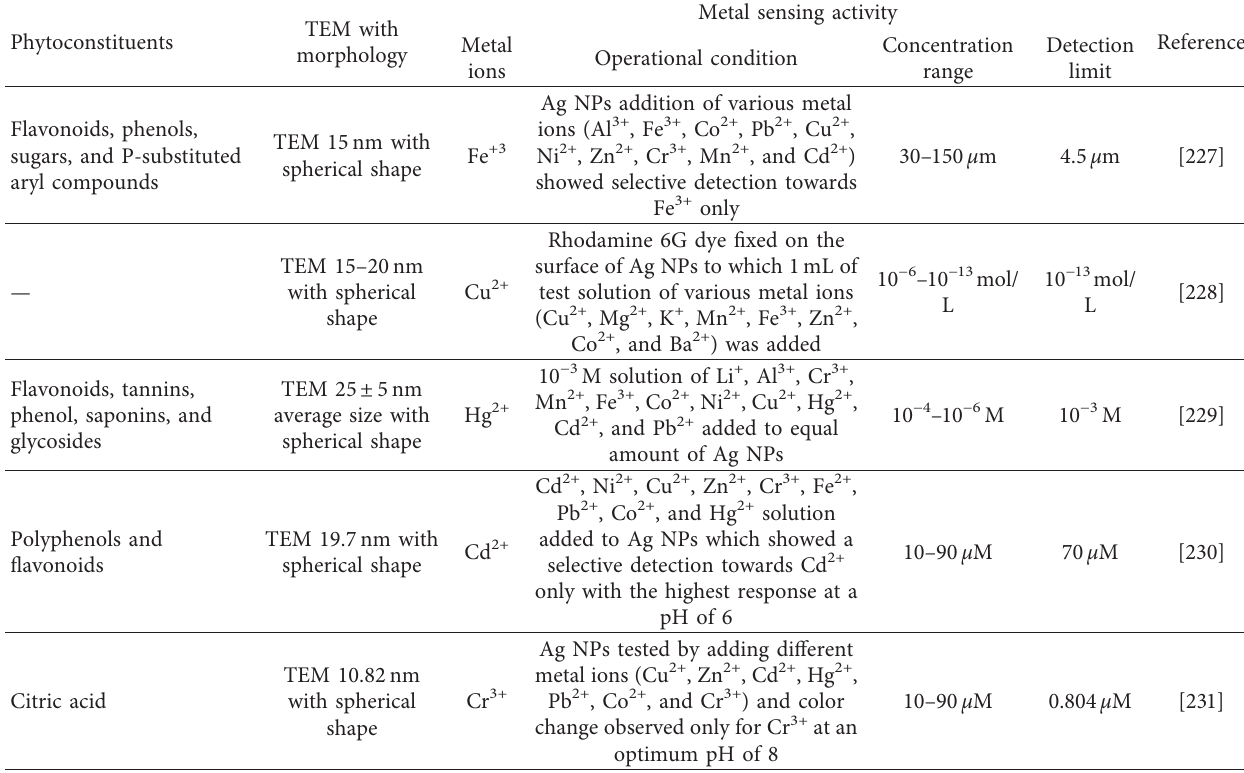
Table 10: Morphology of Ag NPs, their metal sensing activity, and their detection limit.